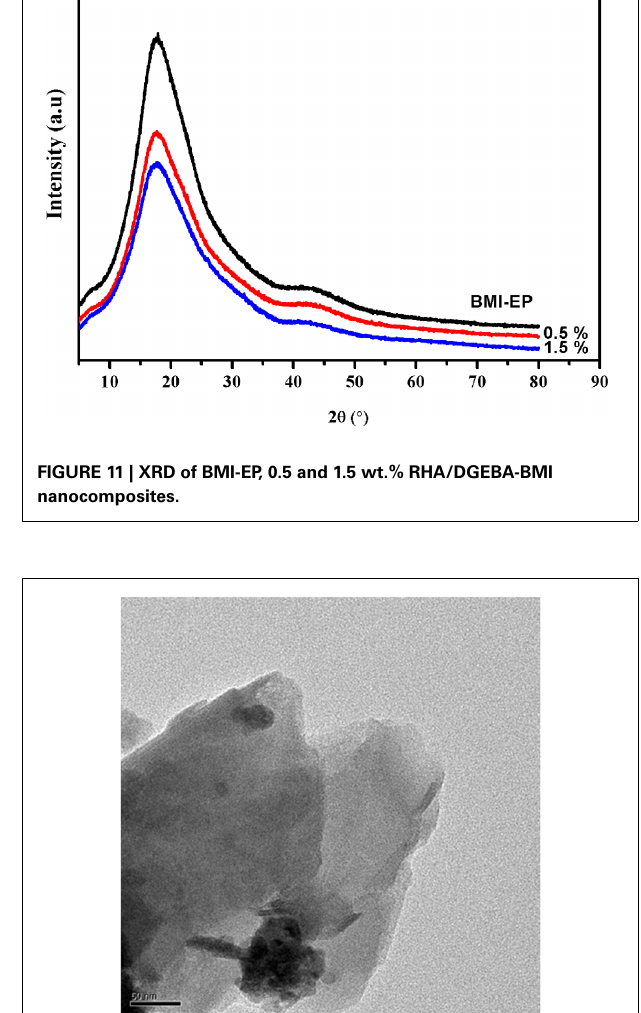
Table 3 | Contact angle and surface energy of RHA/DGEBA-BMI nanocomposites.